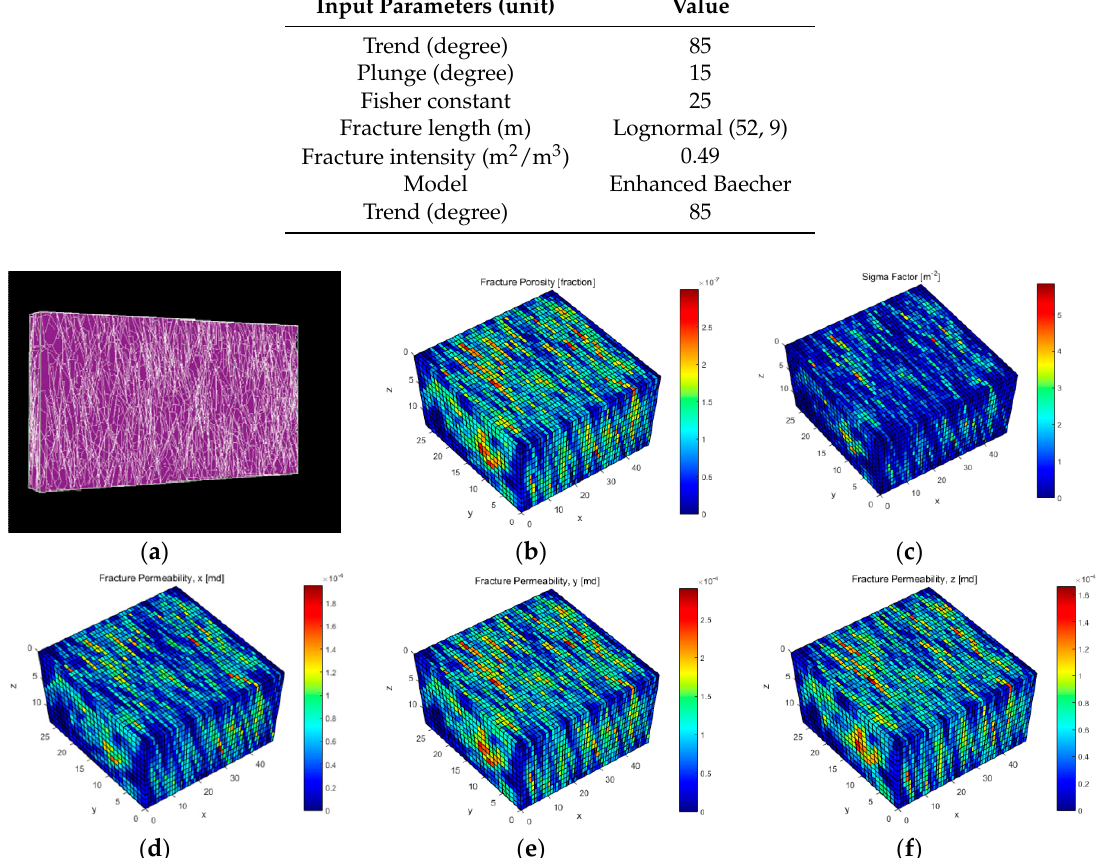
Figure 6. Natural fracture generation and upscaling in 3D grid systems—( a ) natural fracture generation, ( b ) fracture porosity, ( c ) sigma factor, ( d ) fracture permeability, x , ( e ) fracture permeability, y , and ( f ) facture permeability, z .